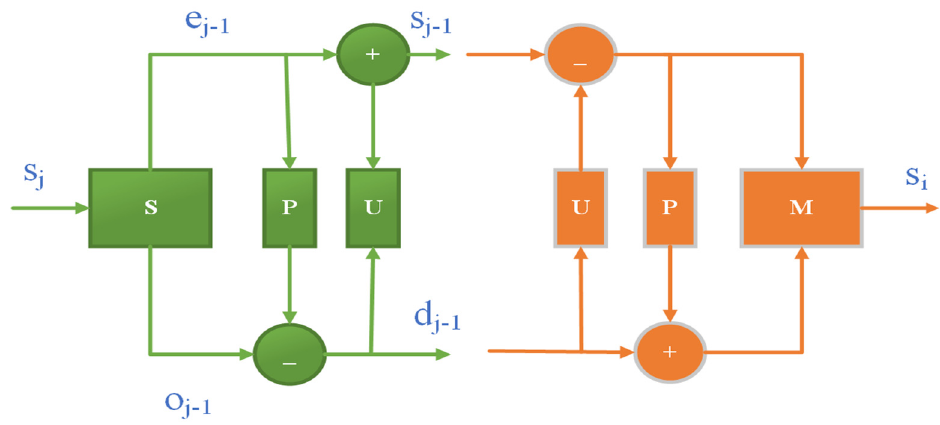
Figure 2. Direct and inverse lifting .